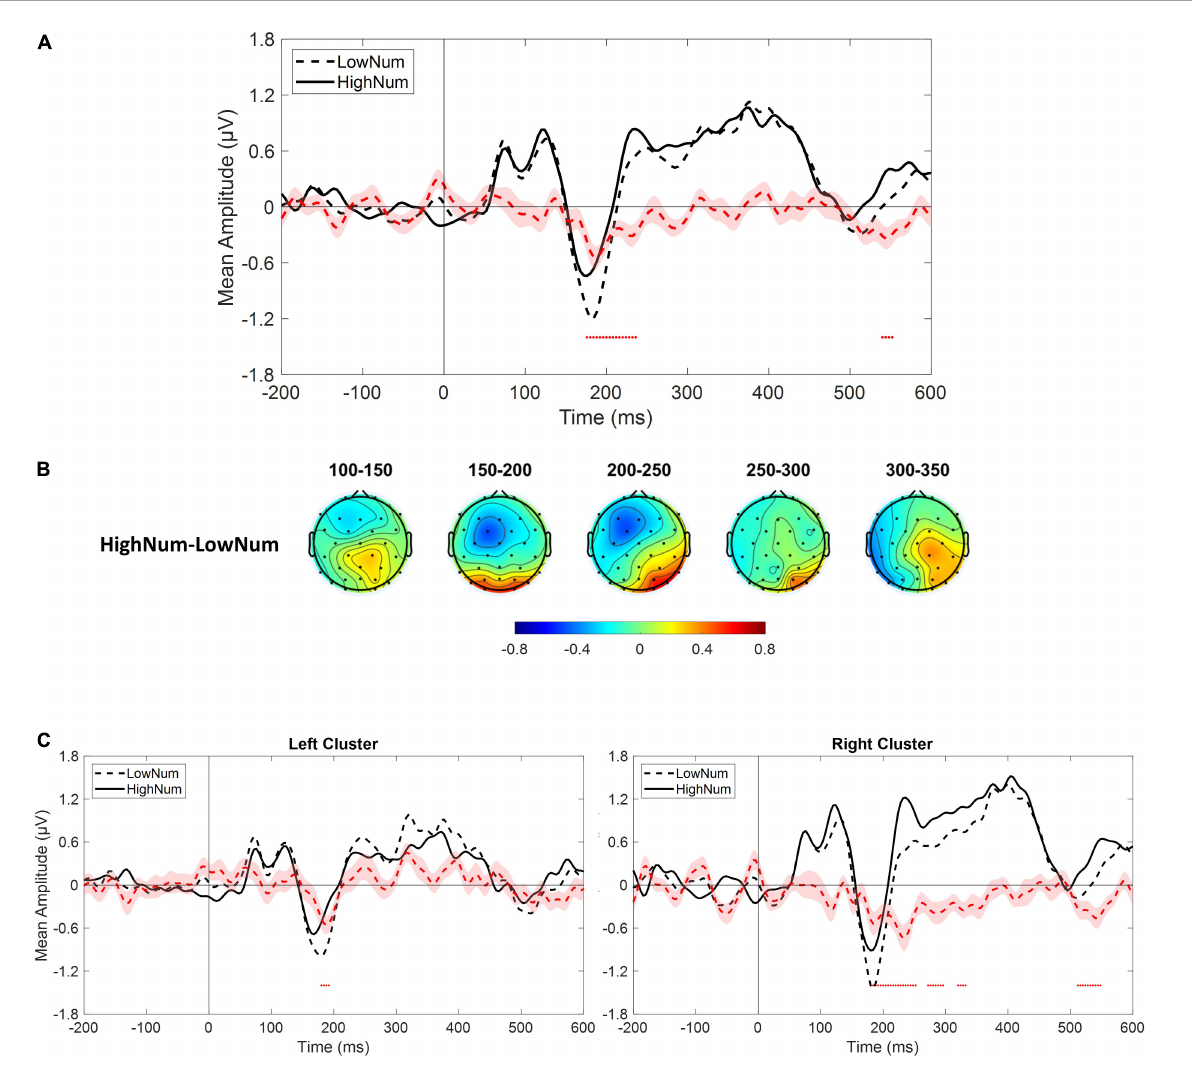
FIGURE5 (A) Event-related potentials (ERPs) response averaged across electrodes P3, P4, P7, P8, PO3, PO4, PO7, PO8, O1, O2 for the presentation of lower numerical stimuli (LowNum condition) and higher numerical stimuli (HighNum condition). (B) Scalp topographies depicting the spatial and temporal distribution of the difference between HighNum and LowNum conditions. (C) ERPs response averaged across electrodes P3, P7, PO3, PO7, O1 (left panel) and P4, P8, PO4, PO8, O2 (right panel) during LowNum (dotted black) and HighNum (solid black) conditions. Red dotted curve always depicts the temporal distribution of the difference (plus standard errors, light red shading) between HighNum and LowNum conditions while red dots depict the time interval of statistical